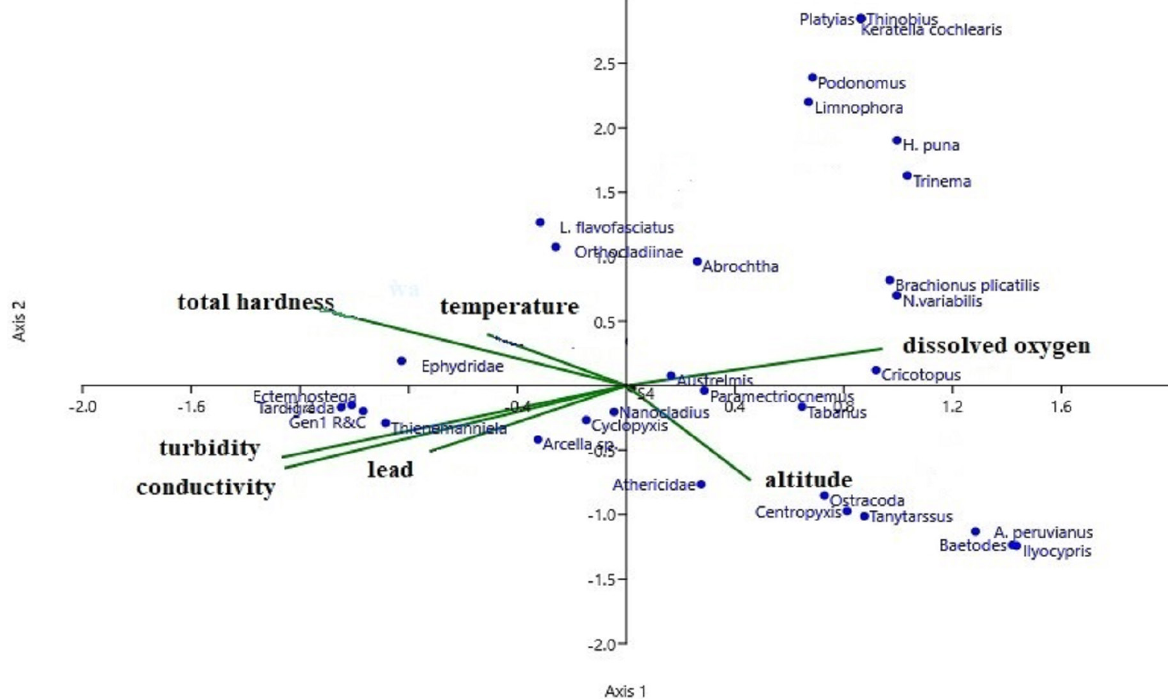
Figure 4. Correlation analysis showing the ordination of the micro and macroinvertebrates taxa registered and the sampling sites with respect to principal physical-chemical, morphometric and granulometric variables. S1-S6 Rosario basin (Salar de Olaroz, Jujuy. Argentina). Canonical correspondence,